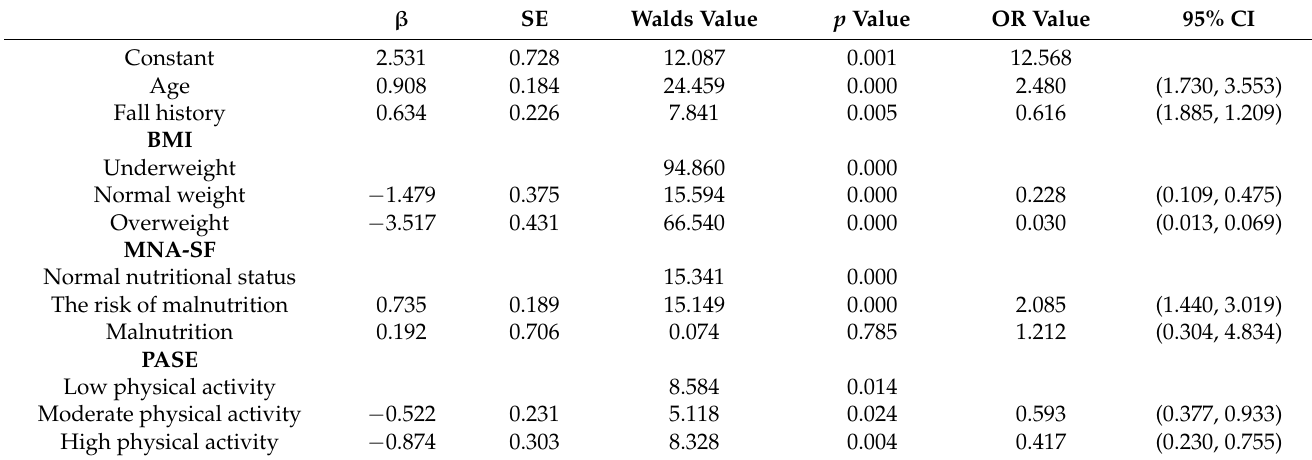
Table 4. Multivariate regression analysis of influencing factors of sarcopenia in the